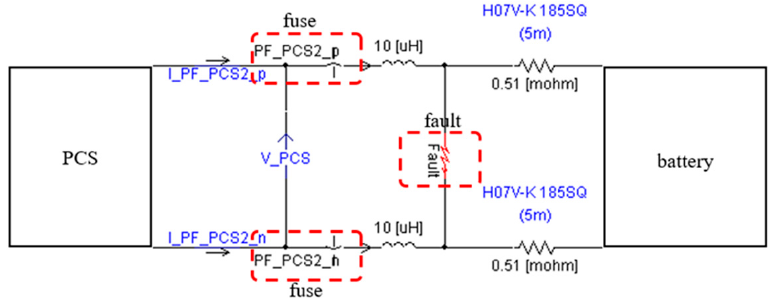
Figure 11. Modeling of fault generator.